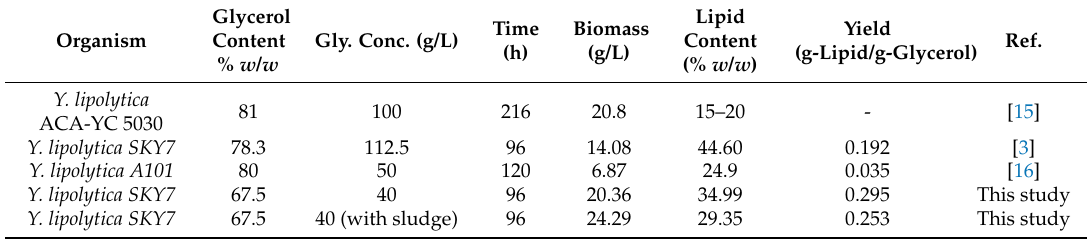
Figure 4. Lipid % ( w / w ) content data for ( A ) Flask fermentations at different sludge solid concentrations; ( B ) Flask fermentation without sludge to compare pure glycerol (SSPG) and crude glycerol (SSCG). Table 5. Lipid production by different strains of Yarrowia lipolytica using crude glycerol from previous